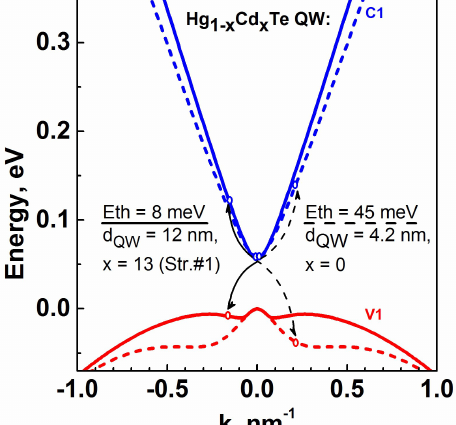
Fig. 2. Calculated energy spectrum of Structure #1 (solid lines) and HgTe/CdHgTe QW with the same bandgap (dash lines), T = 0. Threshold energies and carrier configuration are shown for Auger CCHC